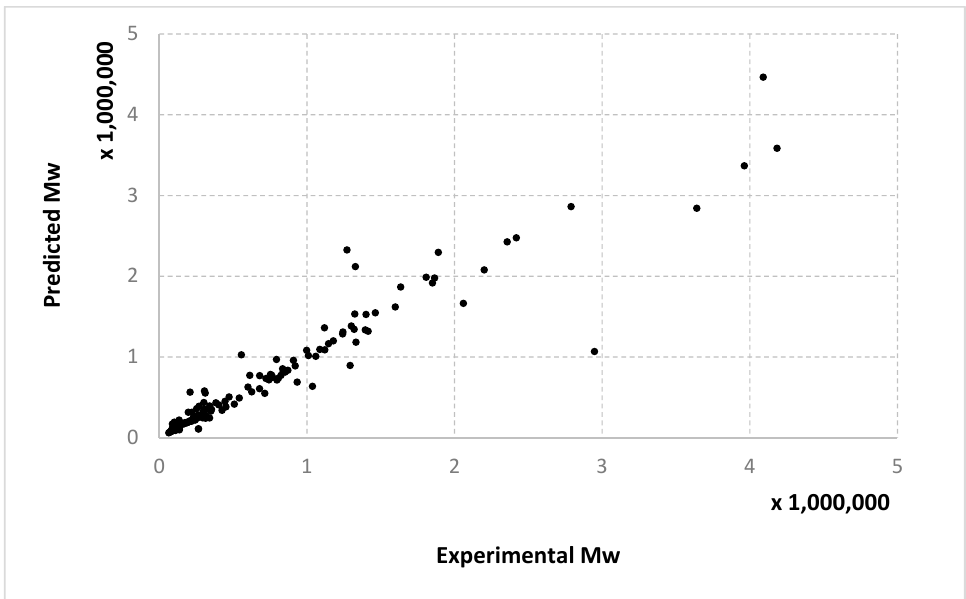
Figure 12. Predicted gravimetrical average molecular weight with the LMNNR-EA algorithm versus experimental data, setting 2, with data split into 90% for training and 10% for testing.